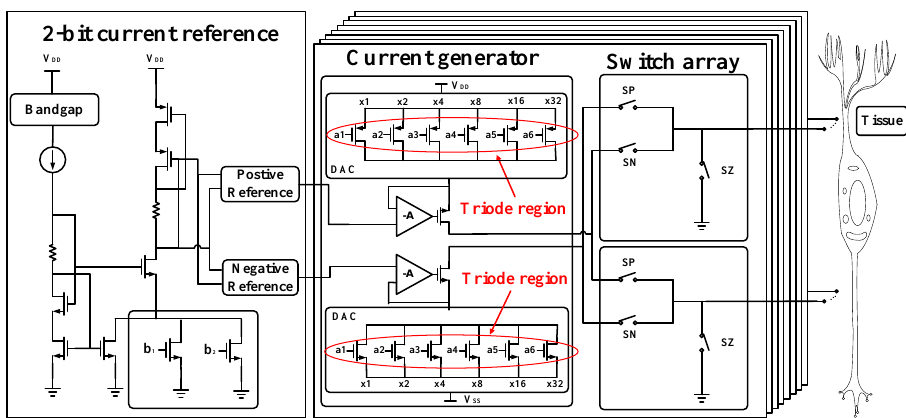
Figure 3. Architecture of the current generator used in the proposed stimulator. It consists of eight-pairs of current generators. Each generator integrates a 6-bit DAC for output current control. Two additional bits, b 1 and b 2 , are used in the reference current mirror to vary the bias voltage. SP is the switch for positive phase, SN is the switch for negative phase, and SZ is the switch for zero